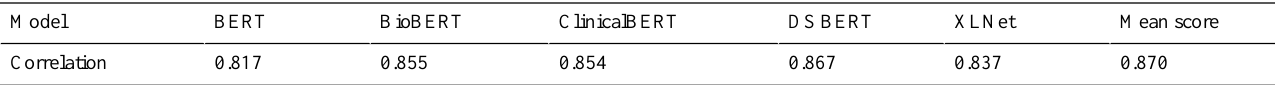
Table 1. Pearson correlation between the ground-truth labels and the predicted labels for each model.